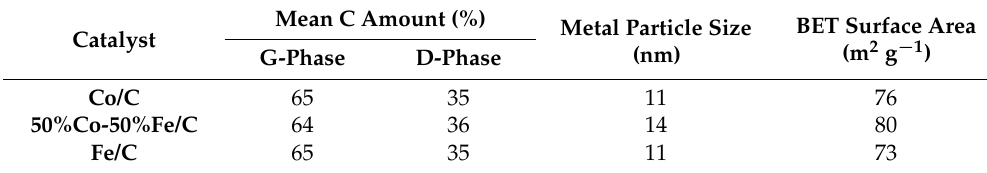
Table 6. The summary properties of the fresh catalysts (averaged